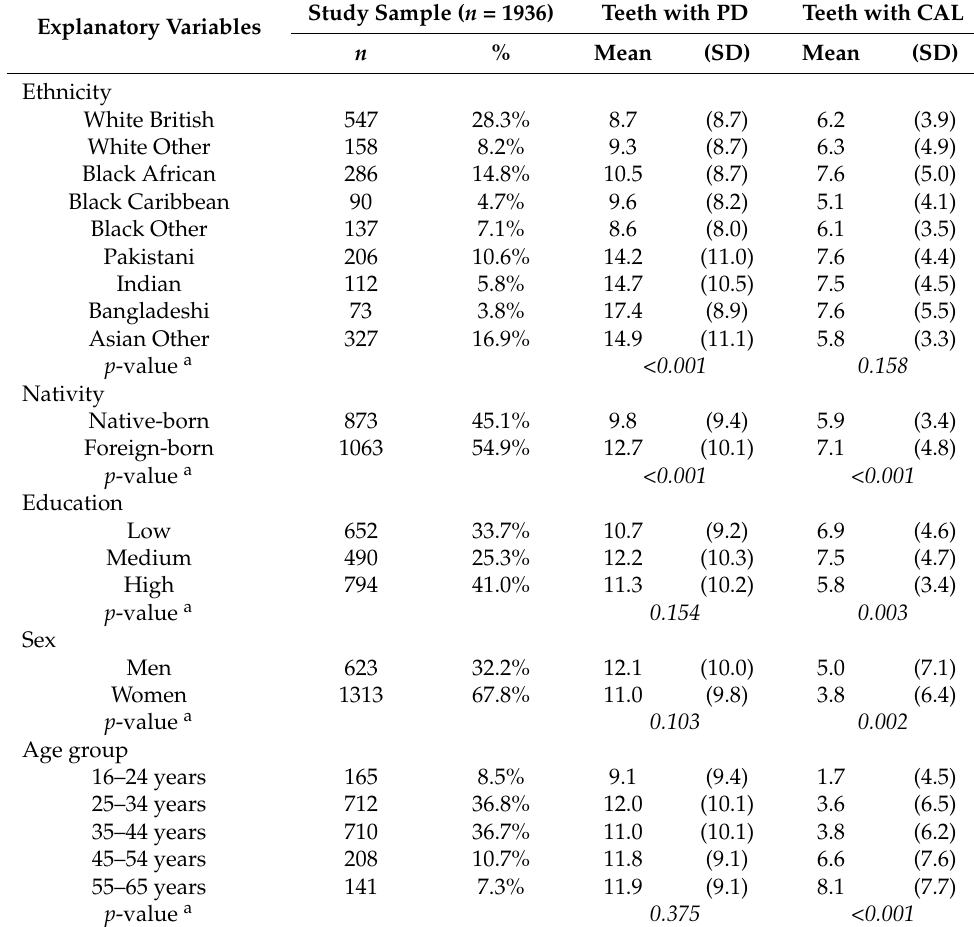
Table 1. Description of the study sample and periodontal measures by explanatory